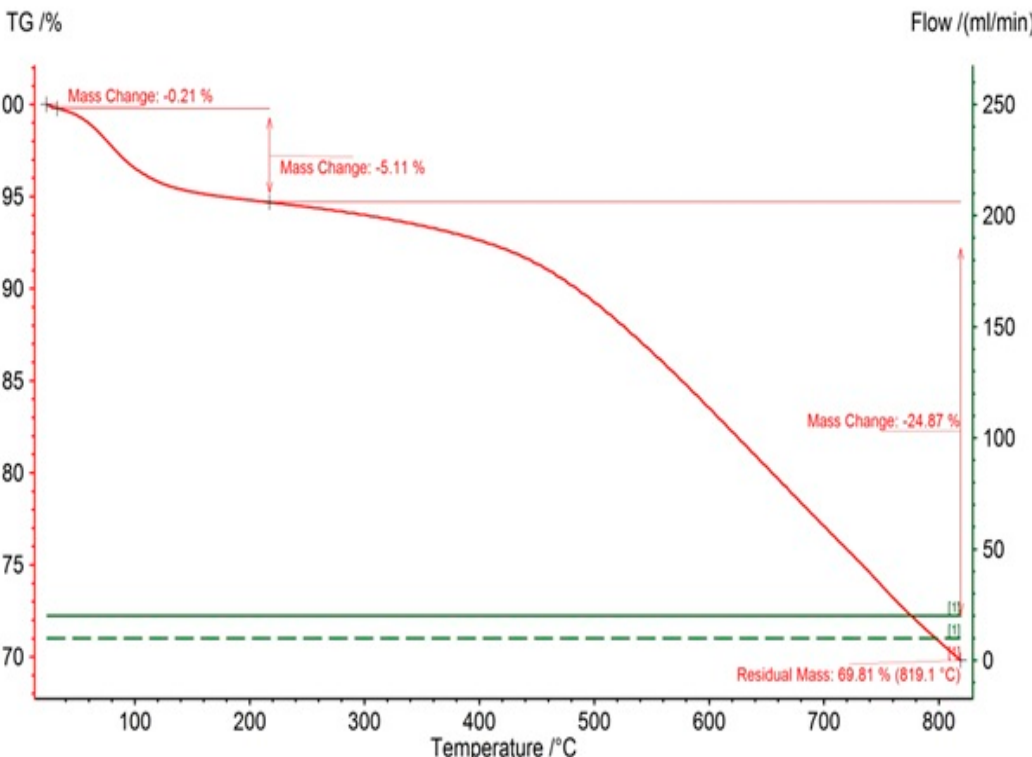
Figure 5. TGA response curve of produced activated